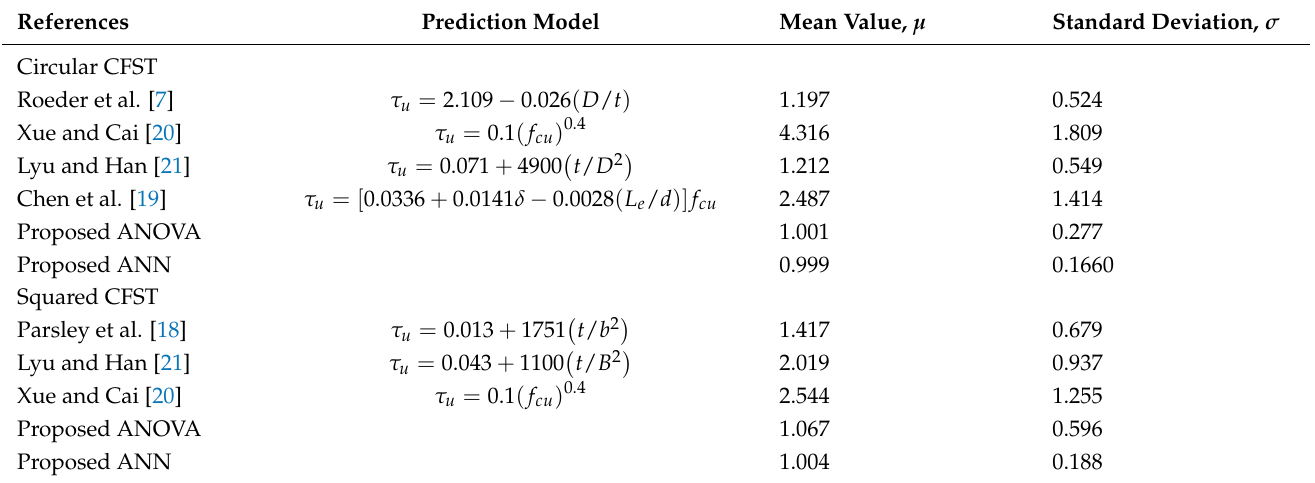
Table 6. Comparison among mean value, standard deviation, and R 2 regarding the ultimate bond